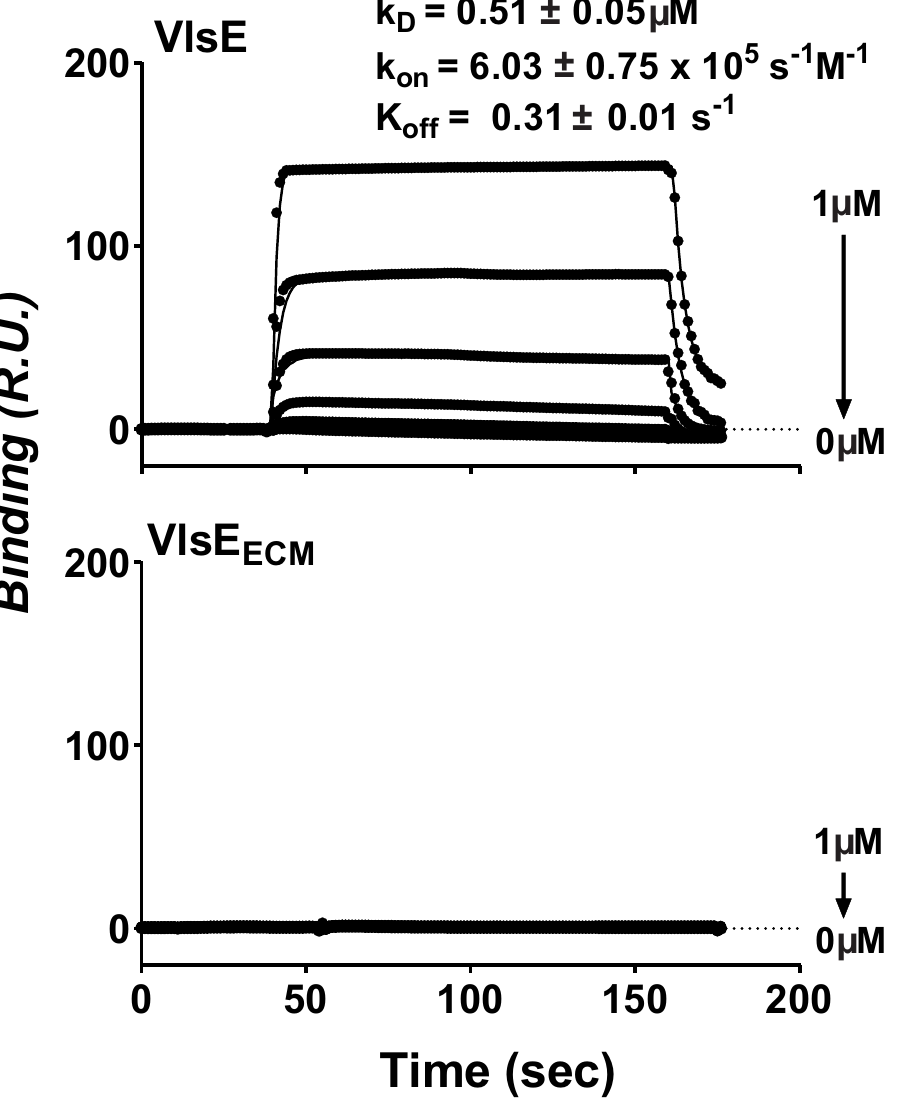
Fig 2. Surface Plasmon Resonance (SPR) to investigate the binding of VlsE to DS. Different concentrations (1000, 250, 62.5, 15.6, 3.9, 0.97, or 0 nM) of recombinant untagged VlsE or a mutated version of VlsE (VlsE ECM ) were individually flowed over a surface of the SPR chip coated with 10 μ g of DS. Binding was measured by SPR. Shown is a representative of six experiments performed on three separate occasions. The mean ± SD of k on , k off , and apparent K D values for VlsE in binding to DS was obtained from these six experiments and shown on the top of the figure. calculated according to the spectra with 60.7 and 62.2% of VlsE and VlsE , respectively ECM composed of α -helix ( S1 Fig ), in agreement with the helix-rich structure of VlsE [29]. The lack of a significant difference in the secondary structure of the two proteins suggests that the amino acid changes introduced to create VlsE did not change the overall structure of the ECM protein ( S1 Fig ). We also verified that VlsE was localized on the surface of B . burgdorferi , ECM as was the wild type protein, using a proteinase-K susceptibility assay when expressed in vivo ( S2 Fig ).